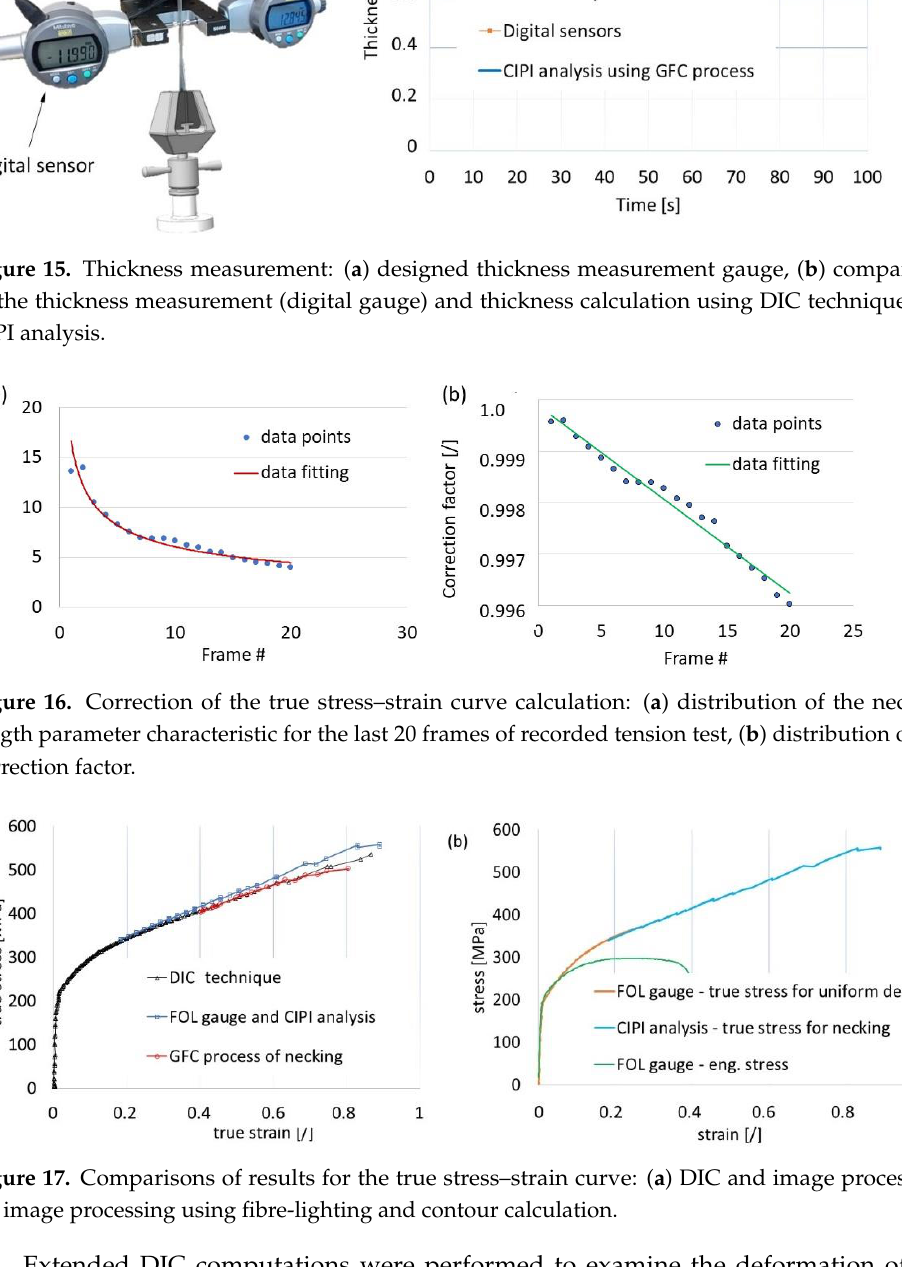
Figure 18. Strain field measurement using DIC: ( a ) specimen view, ( b ) design grid, ( c ) true strain distribution for the stretched area. 4. Conclusions This paper proposed a simple method for measuring specimen deformation during uniaxial tensile testing using FOL gauges and vision technology (the VEIP technique). Elongation values determined in this manner were verified and compared with those obtained with traditional measurement devices, such as analogue extensometers and digital gauges. Deformation measurement using FOL gauges and the VEIP technique and an advanced correlation technique (DIC) proved to be a quick and straightforward way to determine the stress – strain curve for uniform deformation. The strain field distribution was also verified in the FOL gauge zone, and no significant deformations were observed. CIPI analysis and the GCF process are proposed as a precise and rapid method to determine the true stress – strain curve for diffuse necking. To obtain accurate results for deformation during necking, the authors proposed verification of the stress correction factor by describing the changes that occur in necking geometry through Gaussian functions and calculating the specimen thickness, by applying the assumption that the strain components in the latitudinal and thickness directions were equal. The correction factor calculations showed that no stress – strain curve modification was needed for the diffuse necking phase. The proposed solution is an alternative to the DIC technique that involves less advanced computations (i.e., analysis of individual points and contour identification only).